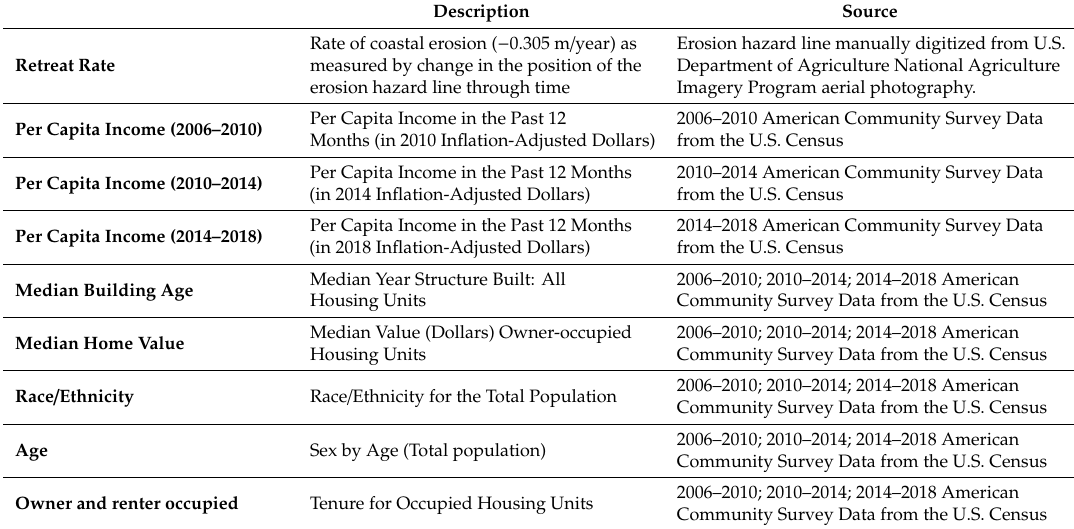
Table 1. Data Description and Sources. Description Source Rate of coastal erosion ( − 0.305 m / year) as Erosion hazard line manually digitized from U.S. Retreat Rate measured by change in the position of the Department of Agriculture National Agriculture erosion hazard line through time Imagery Program aerial